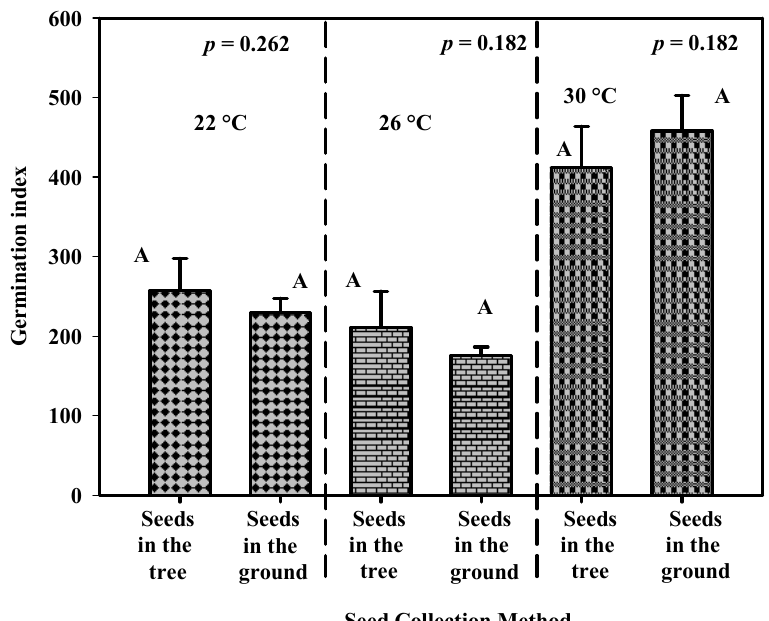
Figure 9. T-test results for the germination index (GI) of D. cinnabari seeds collected from the ground and directly from the crown and evaluated for their germination at temperatures of 22 °C, 26 °C, and 30 °C. Means with the same letter are not significantly different from each other ( p = 0.05).